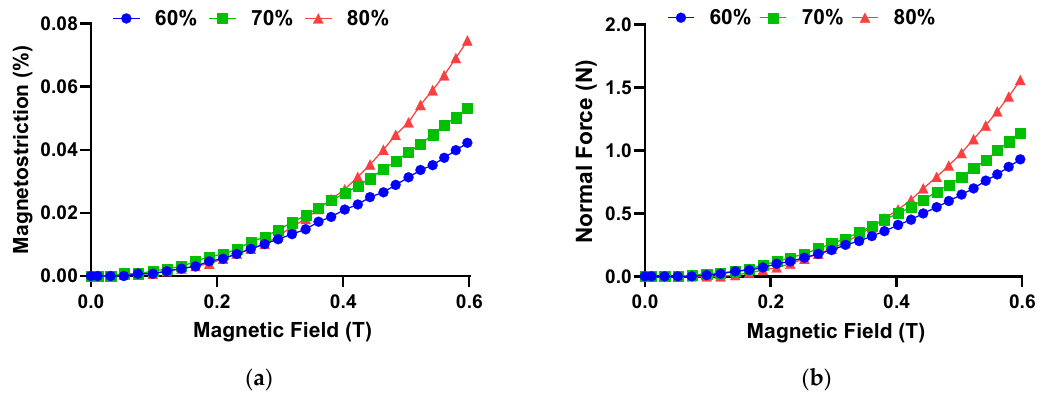
Figure 2. Microstructure of PDMS MREs under magnifications of 1200× with CIPs of ( a ) 60, ( b ) 70, and ( c ) 80 wt.%.